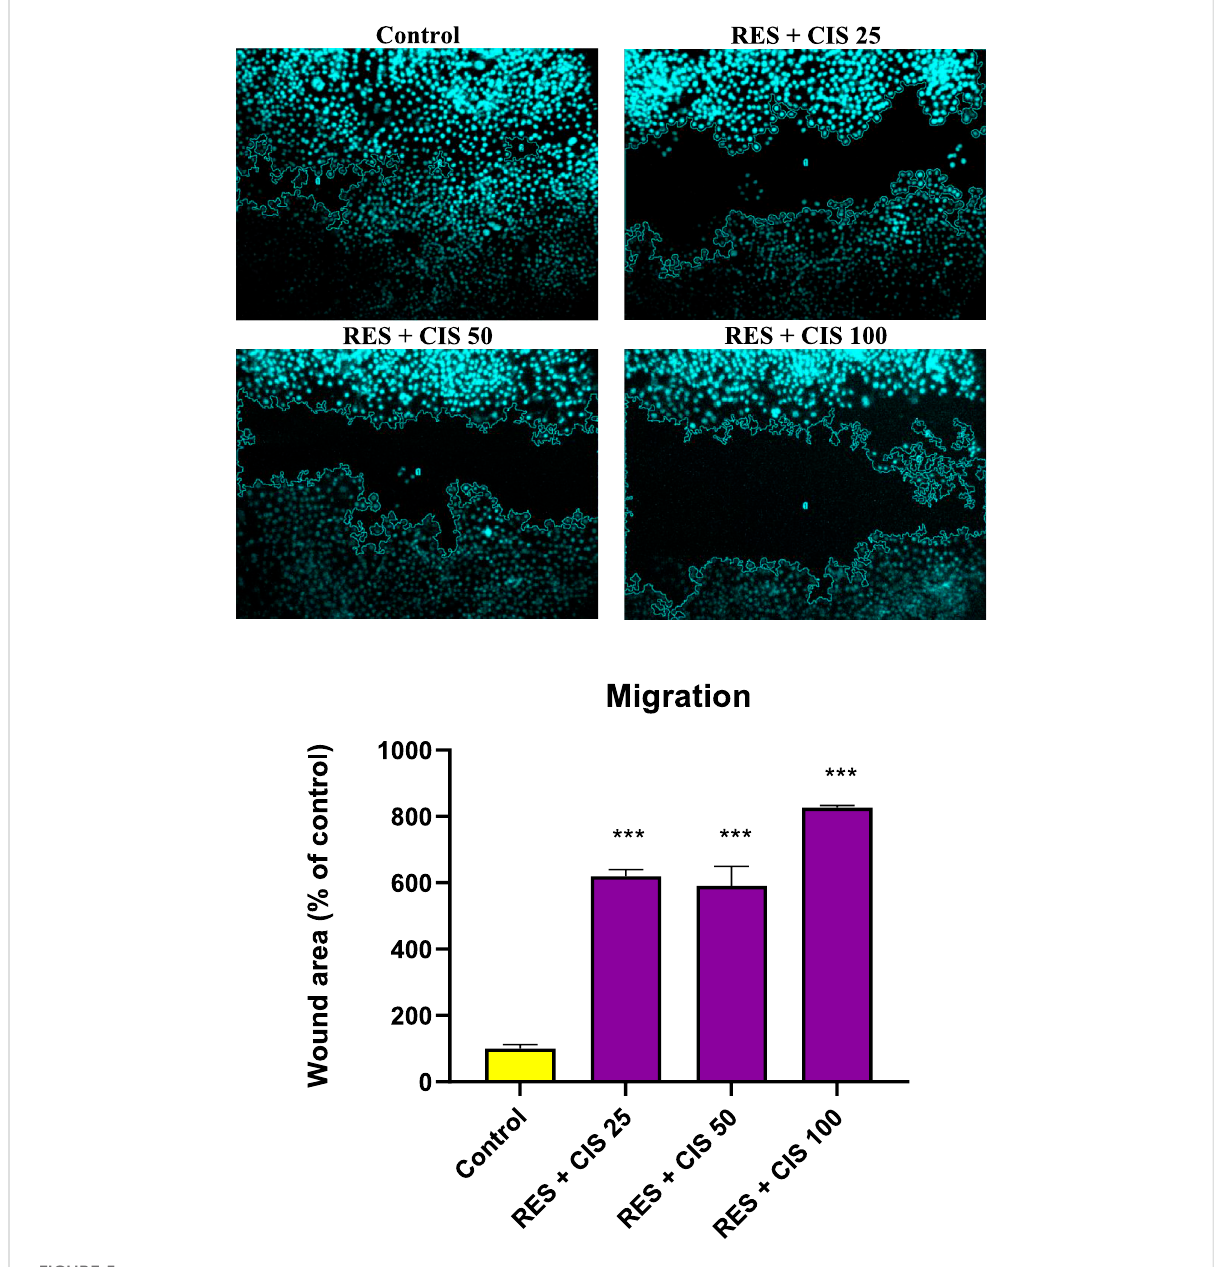
FIGURE 5 Effect of resveratrol (RES) and different concentrations of cisplatin (CIS) (25, 50 and 100 μ g/ml) on the scratch area of adenocarcinoma gastric cells (AGS). Fluorescent microscope images were taken from ×20 magni fi ed cell scratches and analyzed using ImageJ software. The results are expressed as mean ± SD performed on n = 6, with two independent replicates. *** shows signi fi cant change in cell migration compared to the control group ( p <